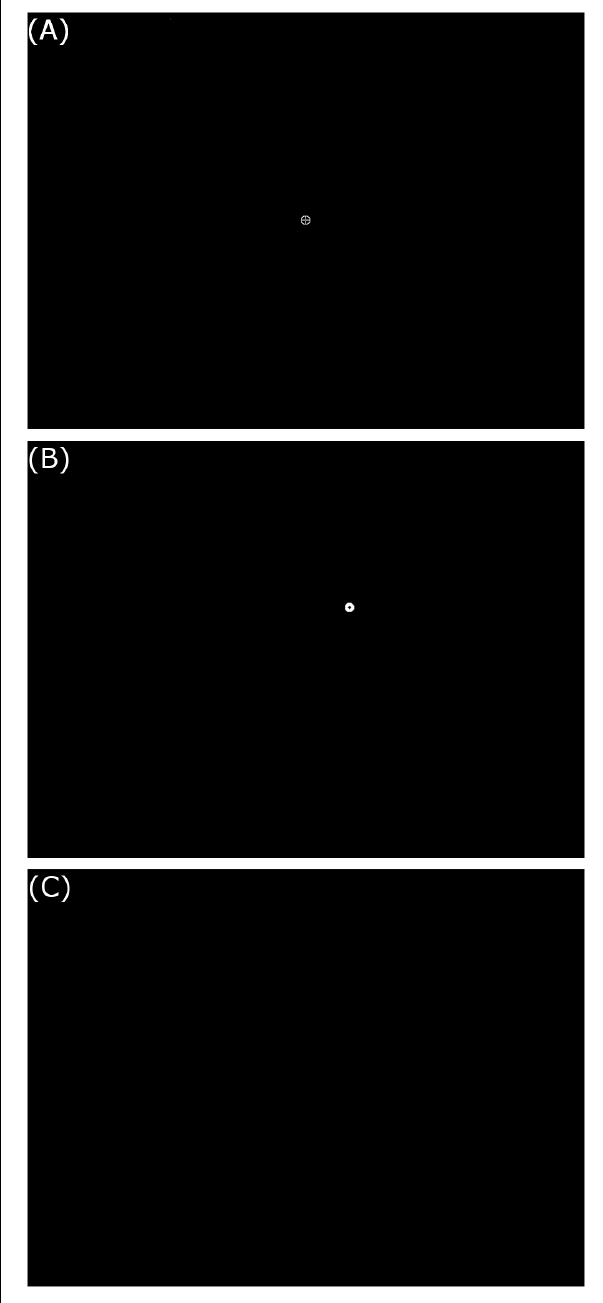
TABLE 7 | OFF-state testing timeline for participants.